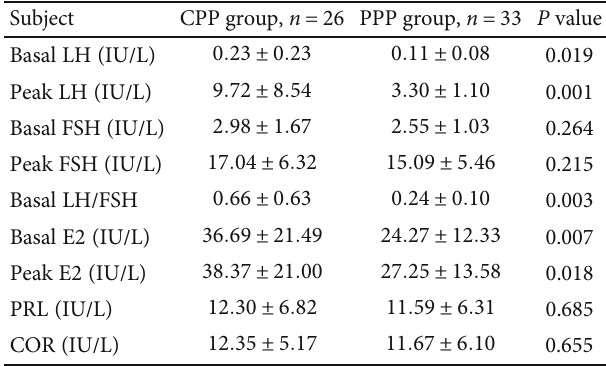
Table 2: HPG axis hormone levels of the two